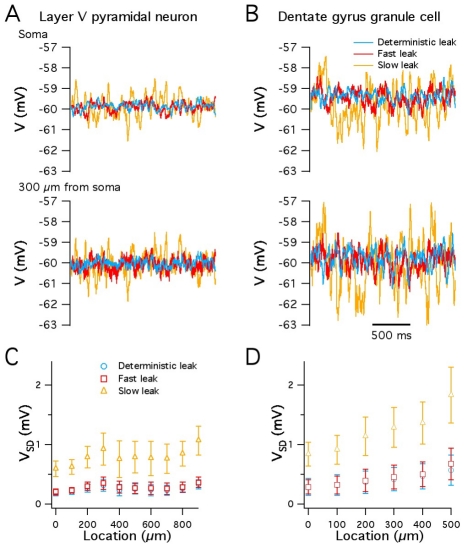
Channel kinetics determine the functional impact of stochastic gating.(A–B) Simulated membrane potential of a model layer V pyramidal neuron (A) and a dentate gyrus granule cell (B) containing either a deterministic leak conductance, fast gating stochastic leak channels or slow gating stochastic leak channels. (C–D) Mean variance of membrane potential fluctuations, recorded from simulated layer V pyramidal neurons (C) and simulated dentate gyrus granule cells (D), plotted as a function of distance from the cell body.